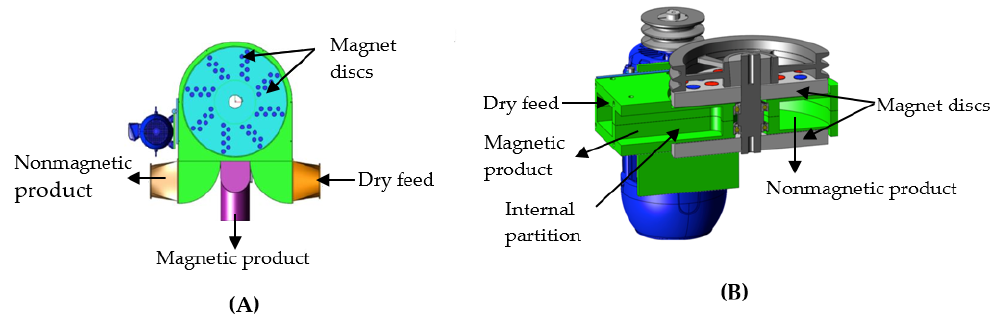
Figure 1. ( A ) PMS cross-section view and ( B ) internal design.